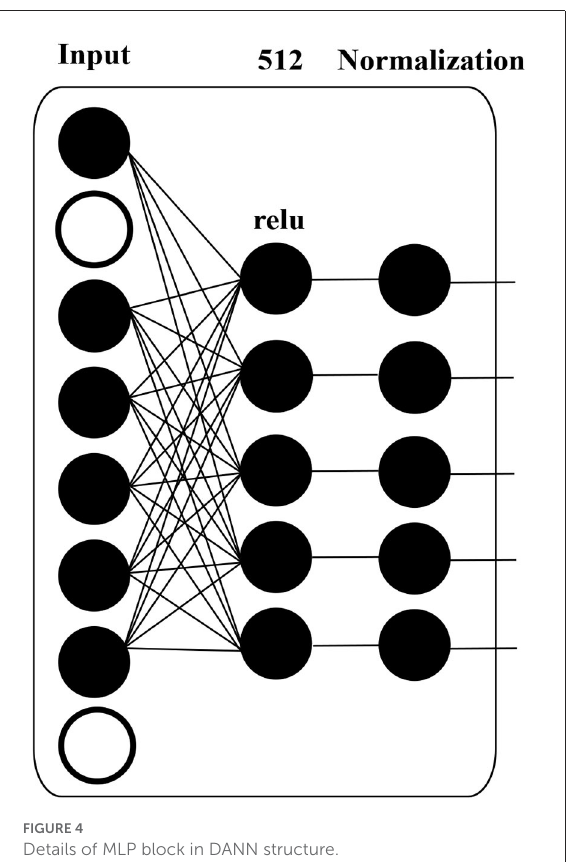
FIGURE4 Details of MLP block in DANN